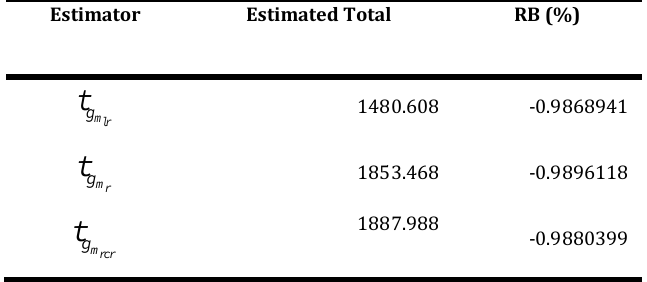
Table-1 represents the results of bias, mean square error and replication variance for the point estimators, based on systematic sampling design with varying probabilities are regression, ratio and regression-cum- ratio estimator. According to table-1 there are regression-cum-ratio estimator which have minimum MSE with smaller but positive bias about (13.0292) than other estimators. The regression and ratio have high MSE but negative bias. From table-1 we can see that the variance estimator using Jackknife replication variance is smaller for ratio while regression- cum-ratio estimator has greater replication variance. Table 2: Relative bias (RB) of Total for the proposed estimators (4,000 samples) Estimator